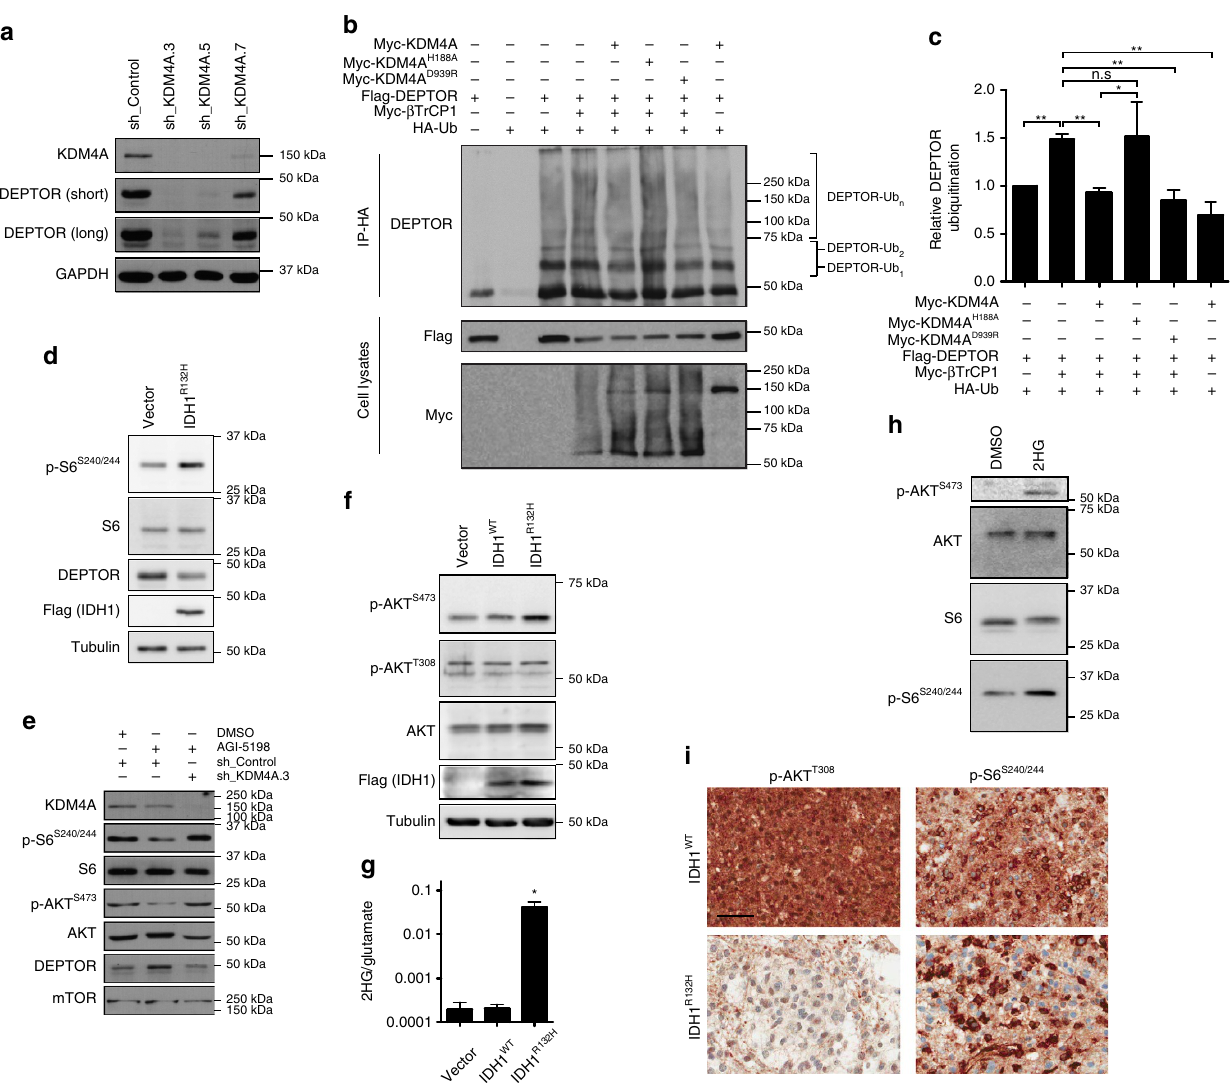
Figure 4 | Functional implication of IDH1/2 mutations in central neuron system-derived cells. ( a ) KDM4A depletion reduces DEPTOR levels. HeLa cells were transduced with lentivirus expressing sh_KDM4A.3, sh_KDM4A.5, sh_KDM4A.7 or sh_Control and whole-cell lysates were blotted to determine DEPTOR levels. ( b ) The demethylase activity of KDM4A is required to block b -TrCP1-dependent ubiquitination of DEPTOR in vivo . HA IP was performed